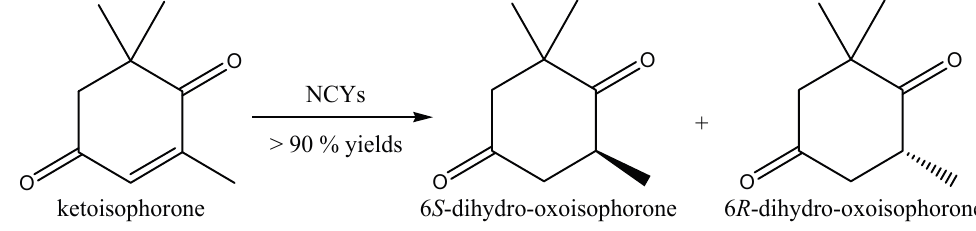
Figure 10. Bioconversion of ketoisophorone by whole-cells of NCYs.